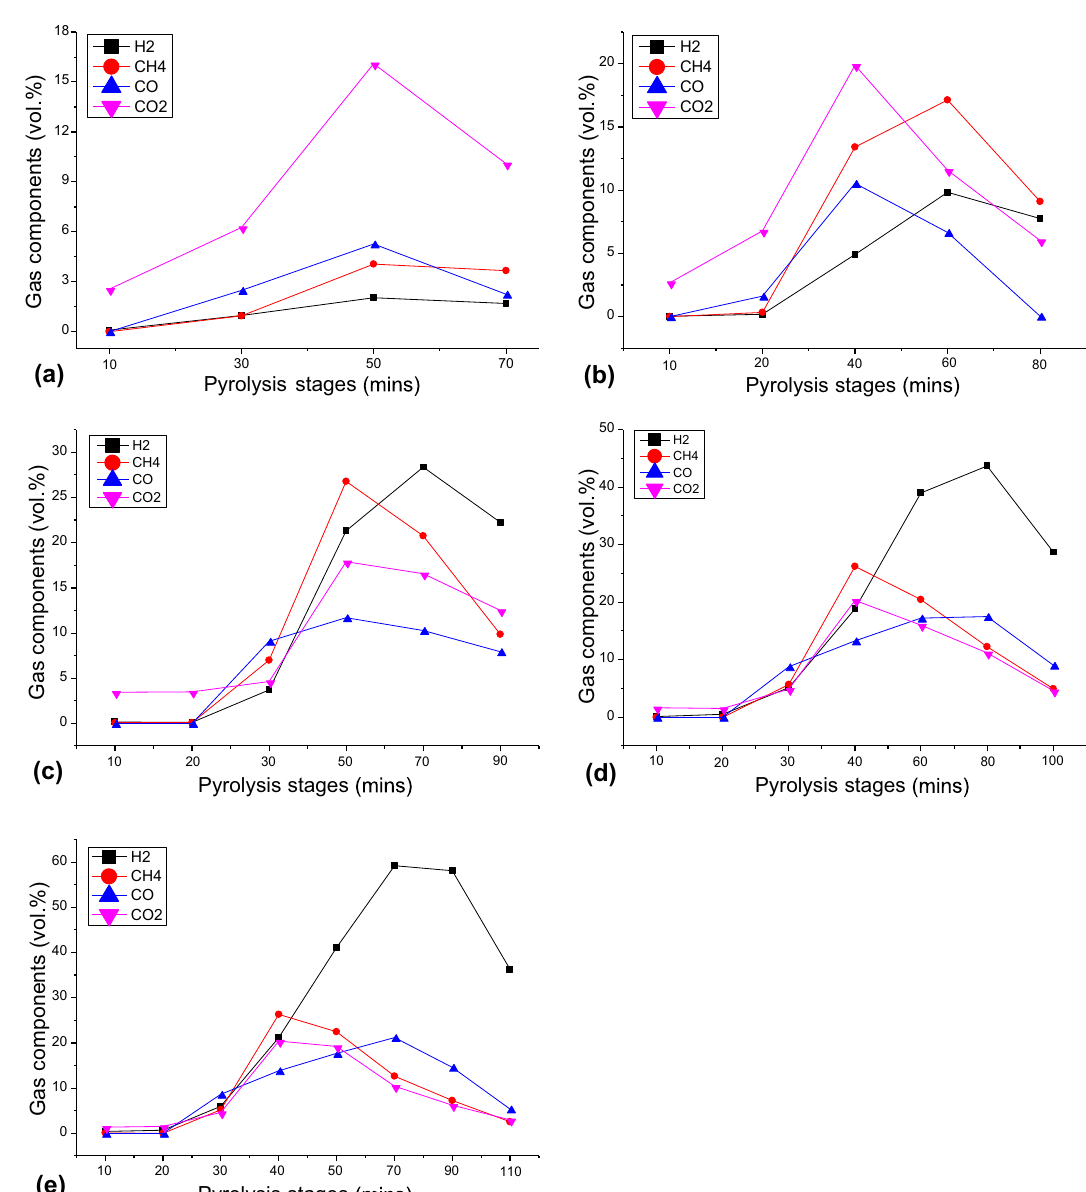
Fig. 7 Gas composition during pyrolysis process of MZH coal, the final temperature of a 400, b 500, c 600, d 700 and e 800 (cid:3) C